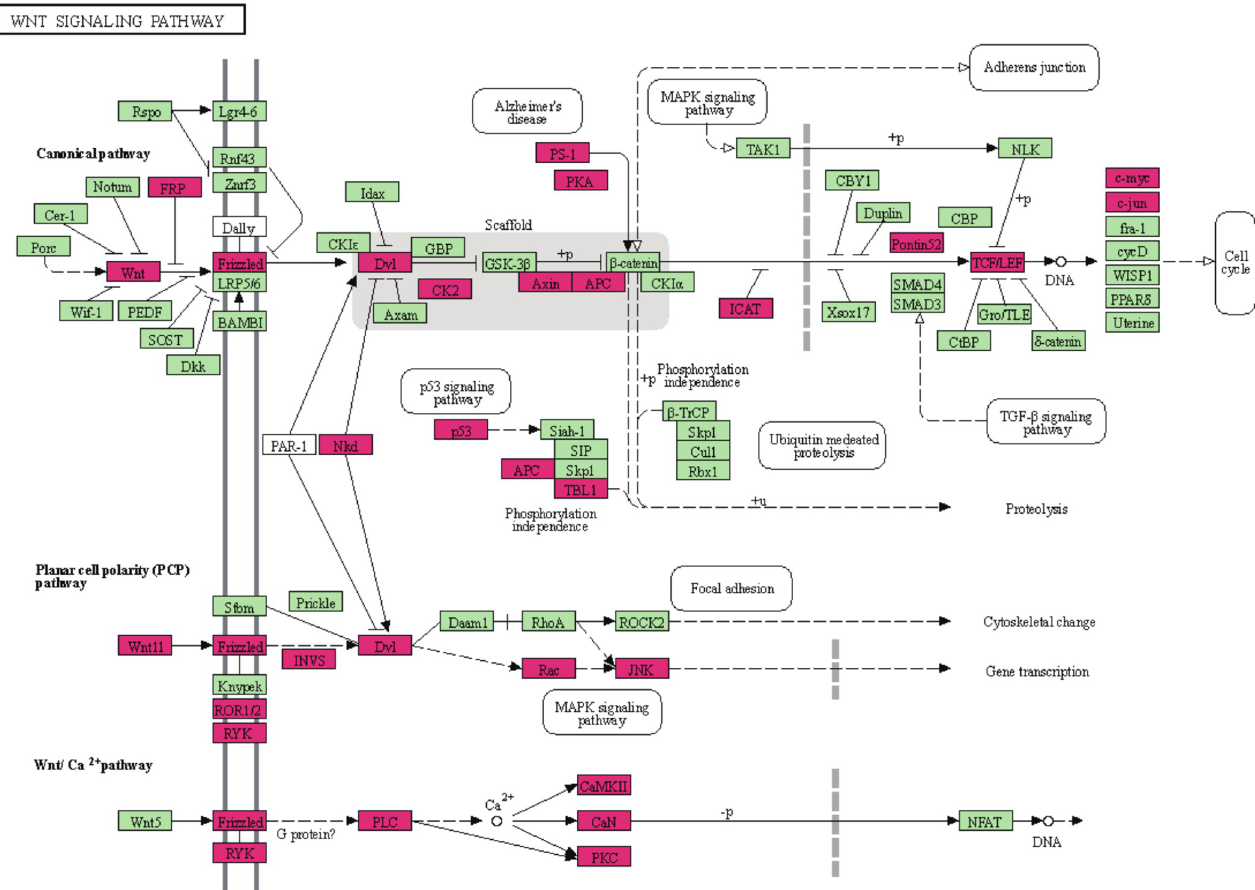
Fig 2. Over- and under-expressed genes are highlighted in WNT signaling pathway. The KEGG pathway map for the human WNT signaling pathway (hsa 04310) was illustrated using the KEGG Mapper; genes correlated with RSPO3 expression are colored in pink.